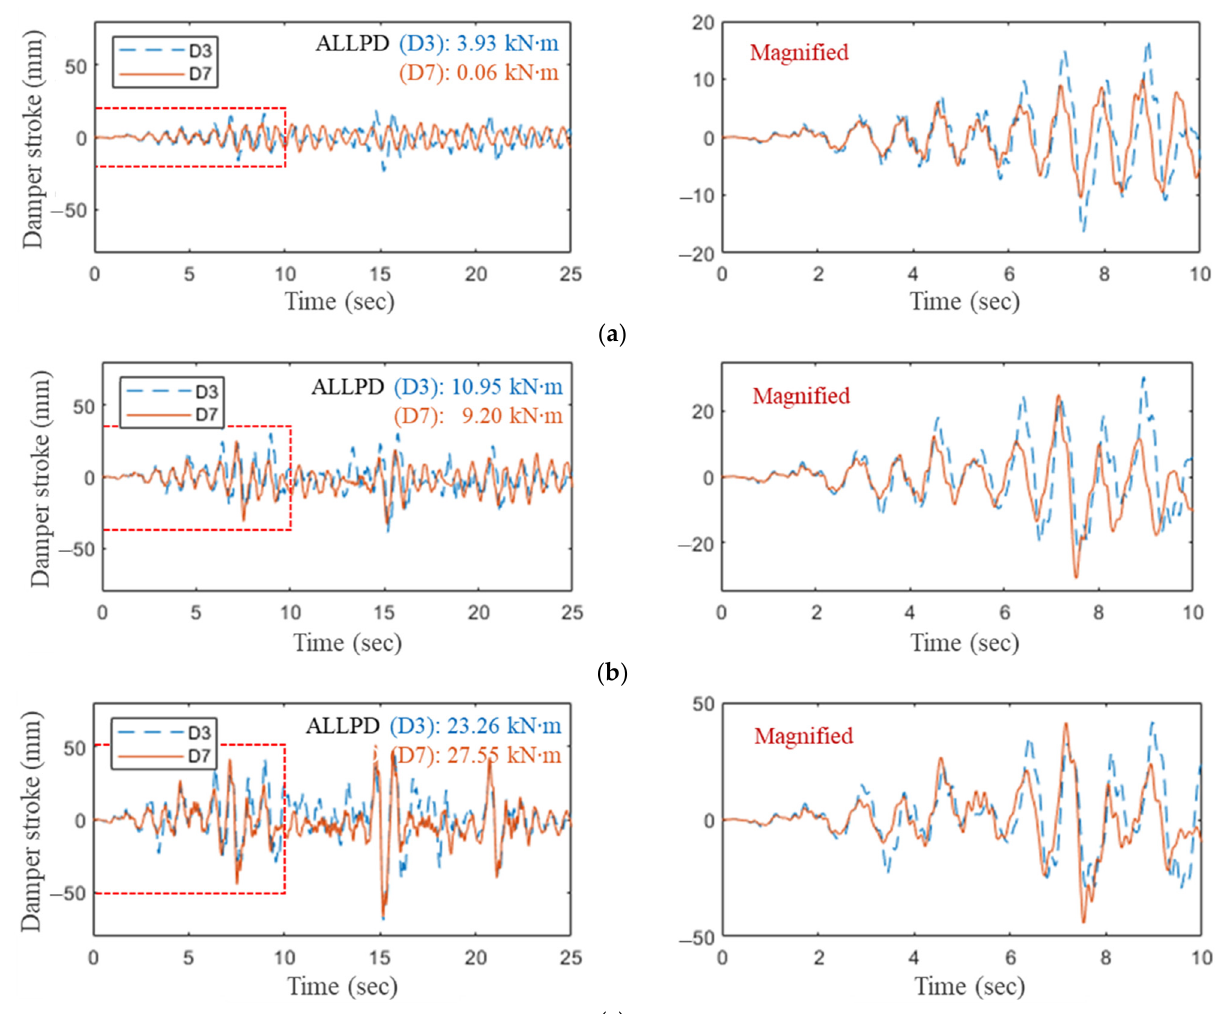
Figure 17. Relative lateral displacement between the upper and lower ends of the damper under artificial earthquake acceleration (Cases D3 and D7): ( a ) Maximum 0.1 g; ( b ) Maximum 0.2 g; ( c ) Maximum 0.3 g.